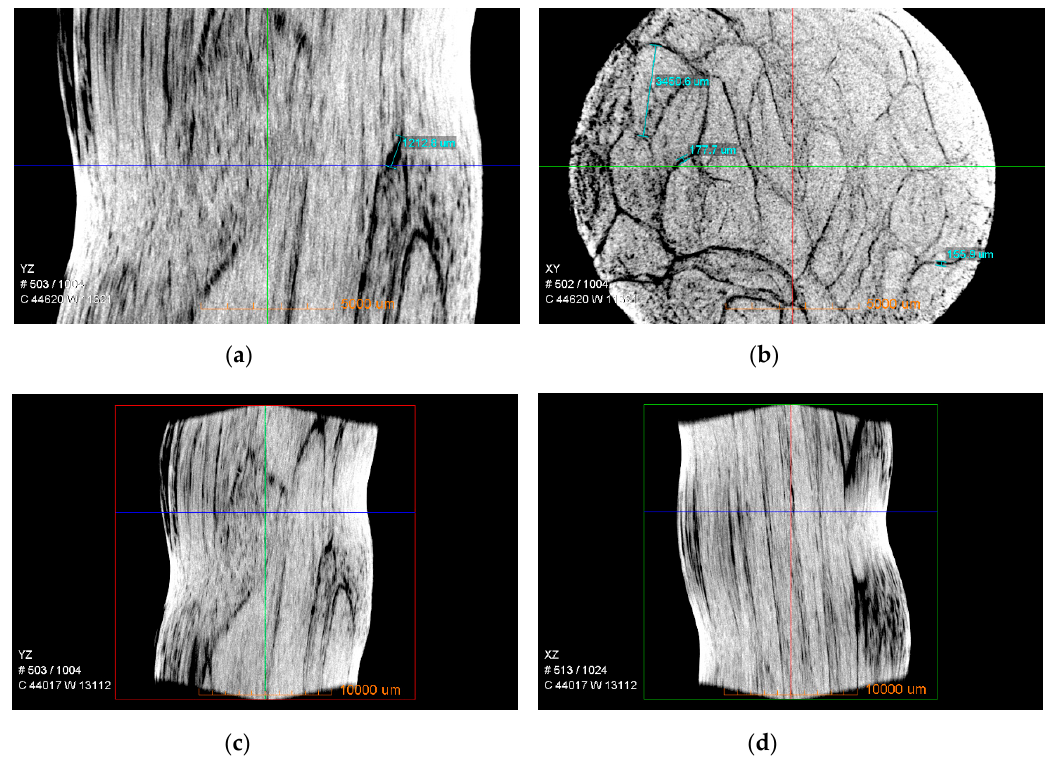
Figure 2. Zeiss 410 Versa XRM and the sample fixed in position.